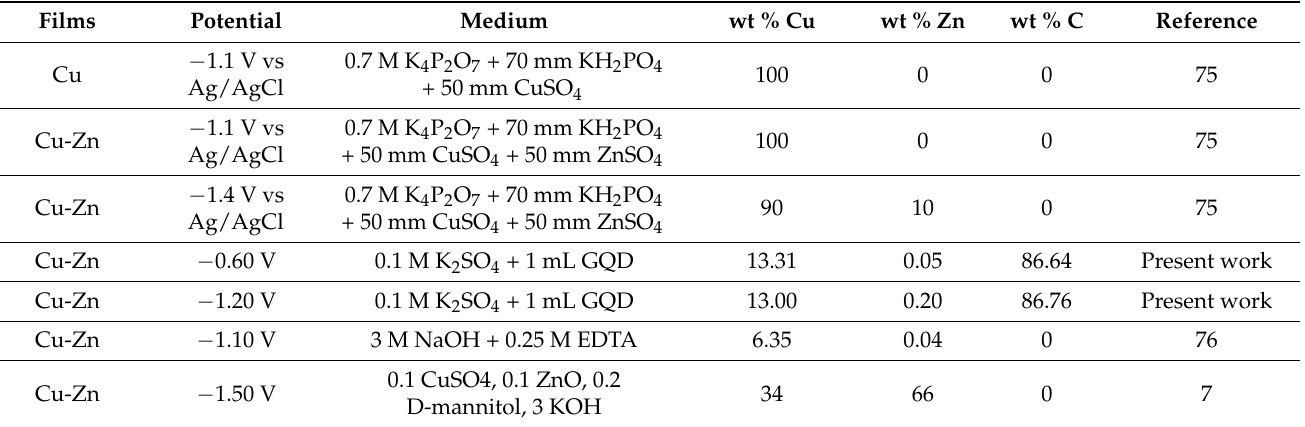
Figure 3. ( A ) AFM recordings of high carbon containing brass. ( B ) Particle size. ( C ) Electrodeposited high C-containing Cu-Zn alloy on a graphite substrate. ( D ) Copper substrate. Table 5. Percentage weight of Cu, Zn, and C in the brass obtained from